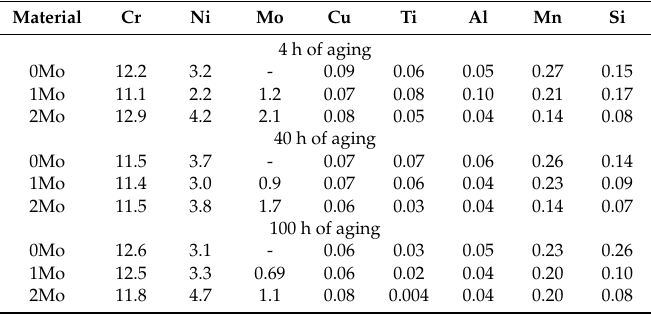
Table 5. Composition of the matrix of the investigated materials (at.%), with Fe as balance.